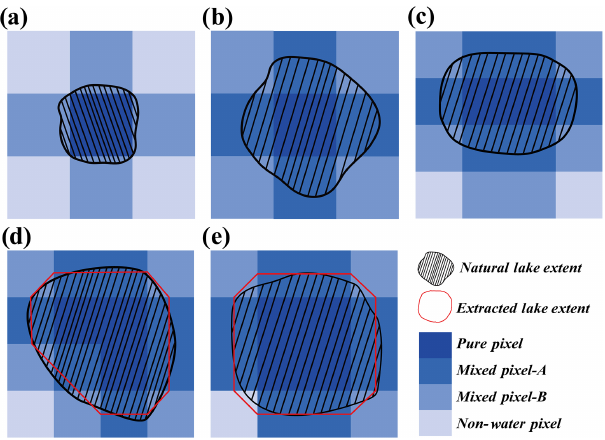
Figure 4. Sketches showing the relationships of pure water body pixels and surrounding potential mixed water body pixels: (a) a pure water body pixel surrounded by 4 potential mixed water body pix- els, (b) a pure water body pixel surrounded by 8 potential mixed water body pixels, (c) 2 pure water body pixels surrounded by 10 potential mixed water body pixels, (d) 3 pure water body pixels with 12 surrounding potential mixed water body pixels, and (e) 4 pure water body pixels with 12 surrounding potential mixed water body